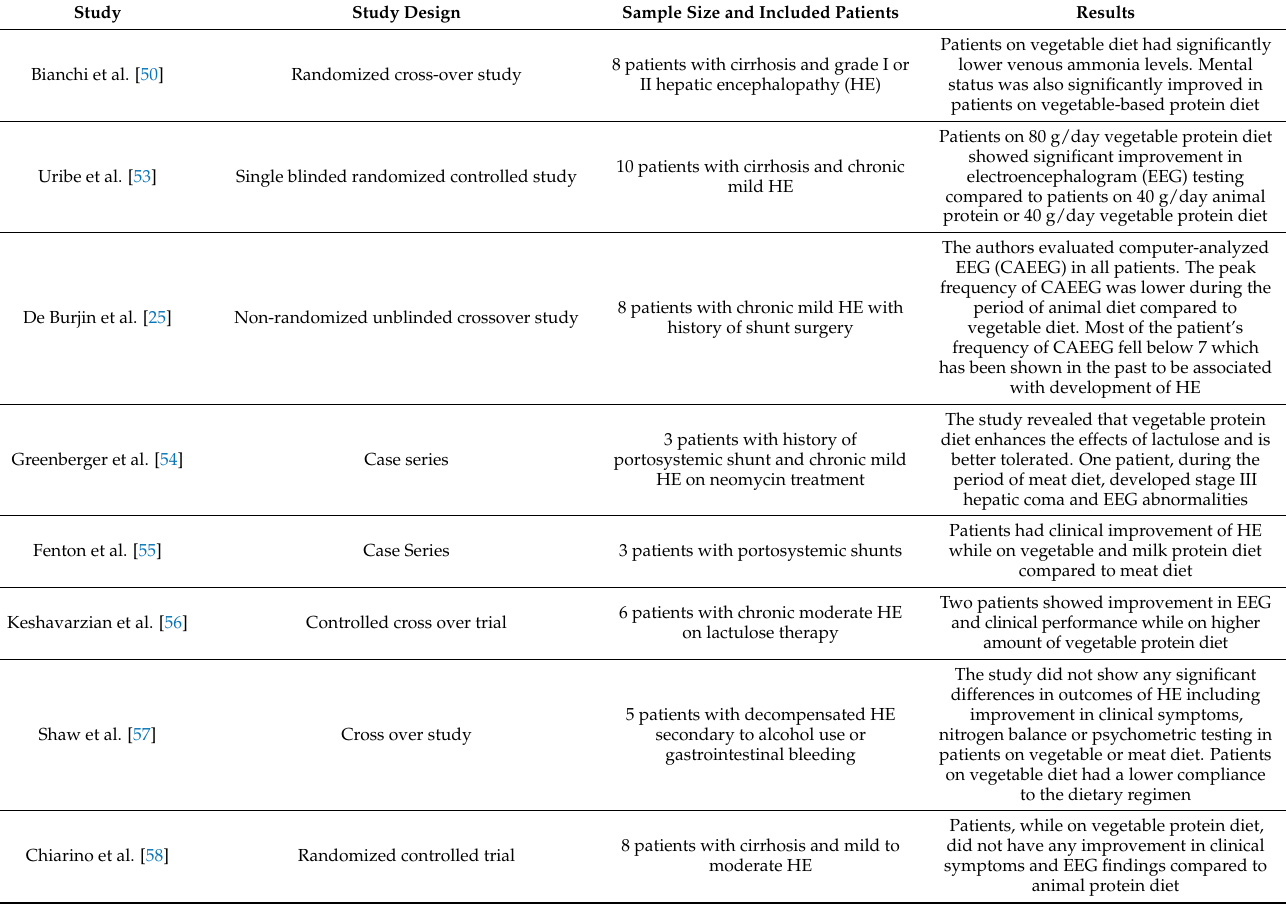
Table 1. Summary of studies comparing vegetable diet and animal diet in patients with